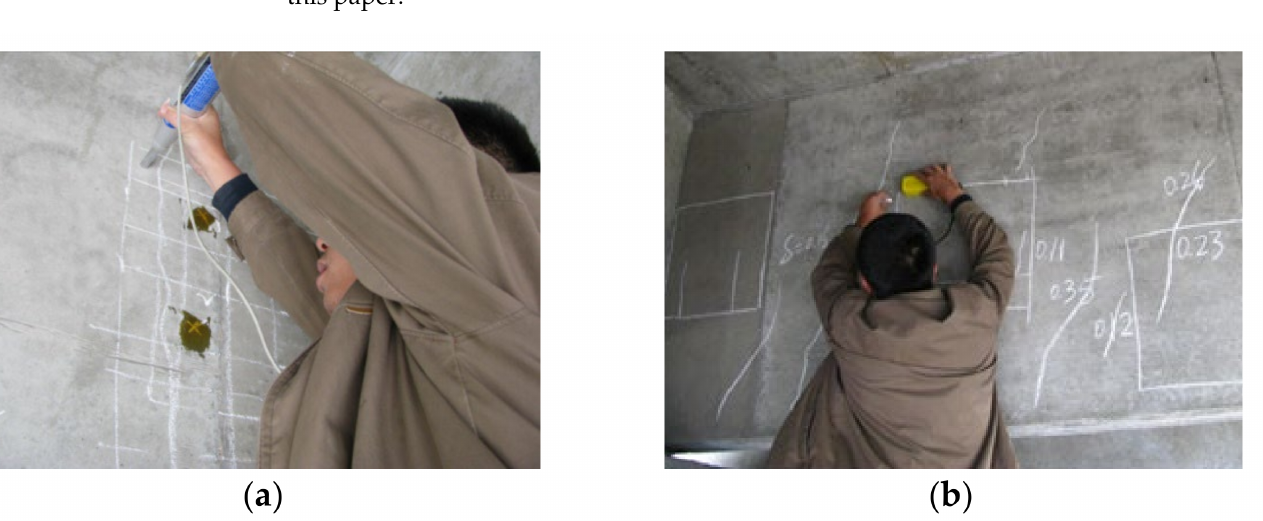
Figure 4. Field test diagram: ( a ) detection of concrete strength; ( b ) detection of concrete cover